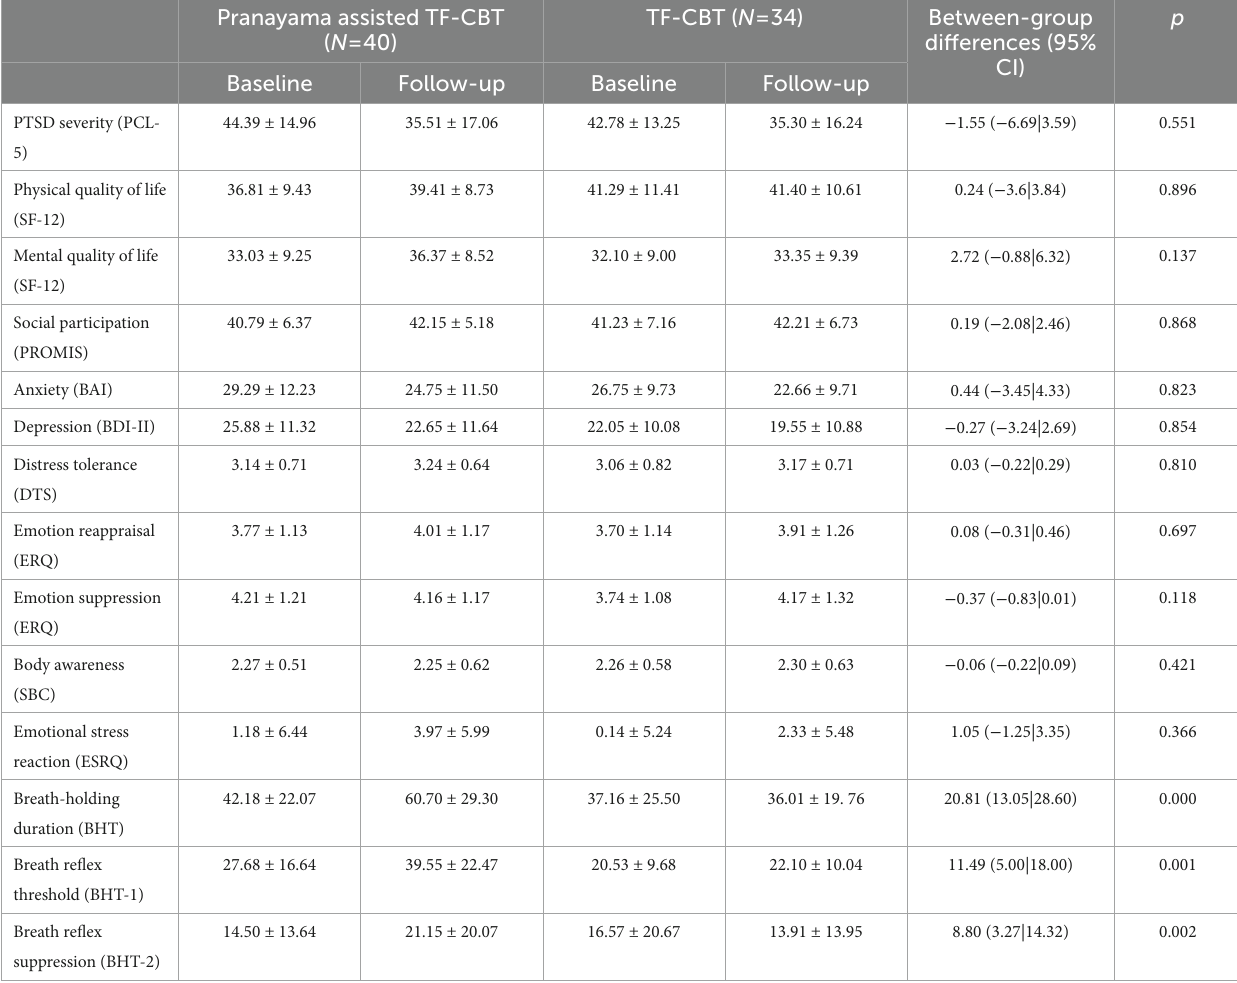
TABLE 4 Results (means and standard deviations) of the intention-to-treat